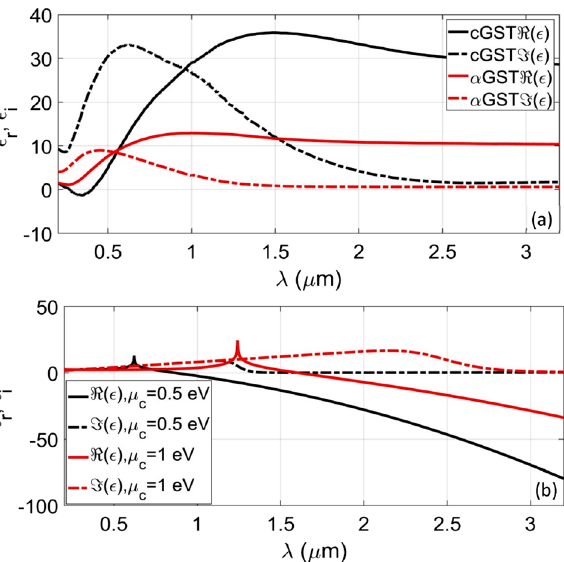
Figure 2. Wavelength dependence of permittivity for ( a ) Ge 2 Se 2 Te 5 in the α - and c -phases, and ( b ) monolayer graphene corresponding to the chemical potential µ c